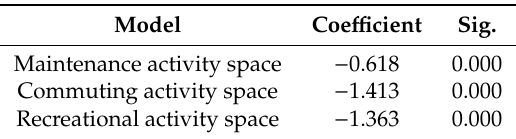
Table 6. The regression results of the three models when POI diversity is calculated with a fixed range of the spatial